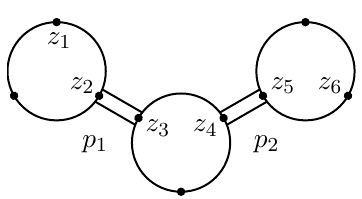
Figure 3. Three 3-punctured discs sewn to give a surface with n = 5 punctures. The z i ’s label coordinate charts centred at the indicated points. We can use the pinching parametrization to (cid:12)nd transition functions between any pair of them in terms of the p i ’s. Note that the centres of z 2 ; : : : ; z 5 get excised from the surface by the sewing procedure.